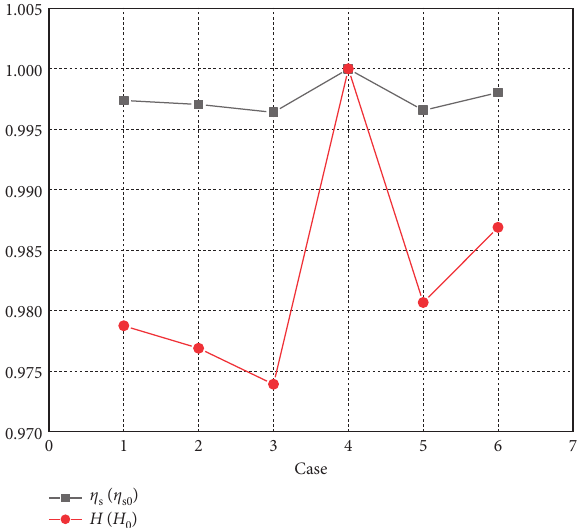
Figure 9: The law of head and system efficiency changing with the length of inlet